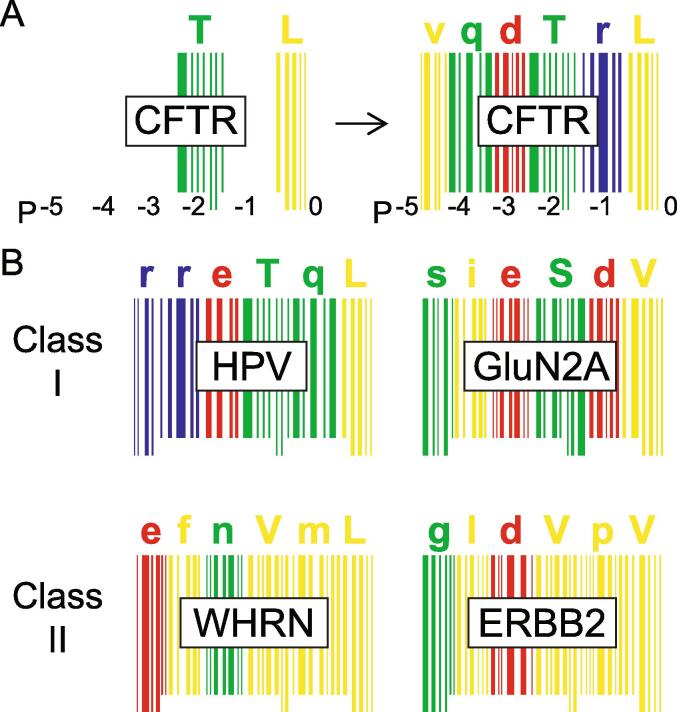
PDZ binding sequences as barcodes. (A) The C-terminal sequence of CFTR (VQDTRL) is shown as a barcode, meaning each residue is represented by a unique pattern of lines with varying thickness. Only motif residues are displayed in the left panel vs. all residues in the right panel. The colors correspond to the stereochemical nature of each residue: positively charged residues are blue, negatively charged residues are red, hydrophobic residues are yellow, and polar residues (including glycine) are green). Motif positions are shown as uppercase letters. (B) Additional common Class I (top panels) and Class II (bottom panels) PDZ binding targets are shown: HPV16 E6 (RRETQL), NMDA receptor subunit GluN2A (SIESDV), whirlin (WHRN, EFNVML), and receptor tyrosine-protein kinases erbB-2 (ERBB2, GLDVPV), are highlighted. The barcode analogy emphasizes that even similar sequences, particularly of the same binding class, can contain varied position-specific chemical and physical properties. (For interpretation of the references to colour in this figure legend, the reader is referred to the web version of this article.)